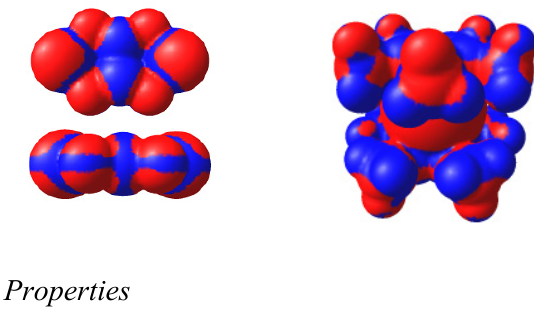
Figure 15. Spin density ( ρ ) distribution over the VdW surface of RA of compound 22 (left) and cation [CrCp* ] + (right) from the UB3LYP/6-31+G(d) calculations. Color code: 2 red, ρ > 0; blue, ρ < 0.